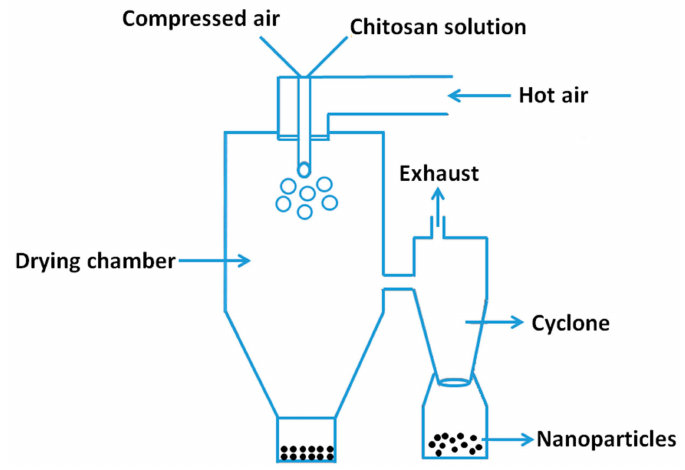
Figure 7. Preparation of chitosan particulate systems by spray drying method.